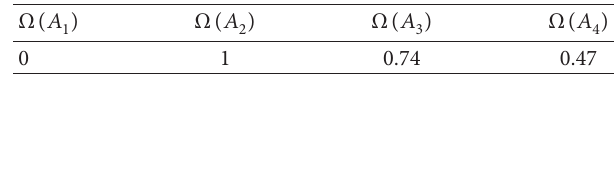
Table 18: The results of 4